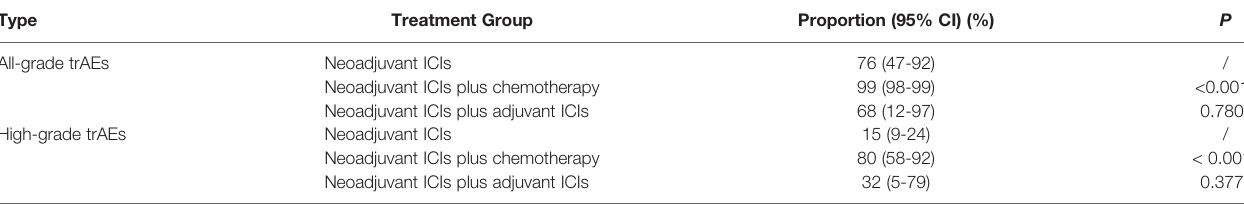
TABLE 1 | Comparison of the incidence of treatment-related adverse events in different treatment groups.